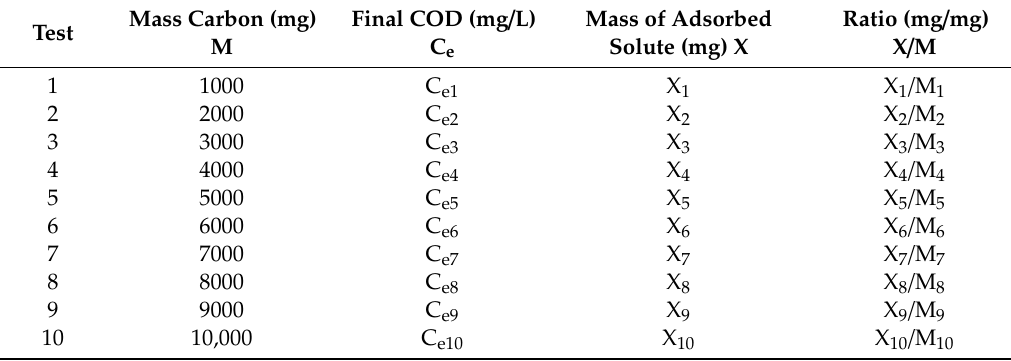
Table 7. Analysis of data obtained in the adsorption